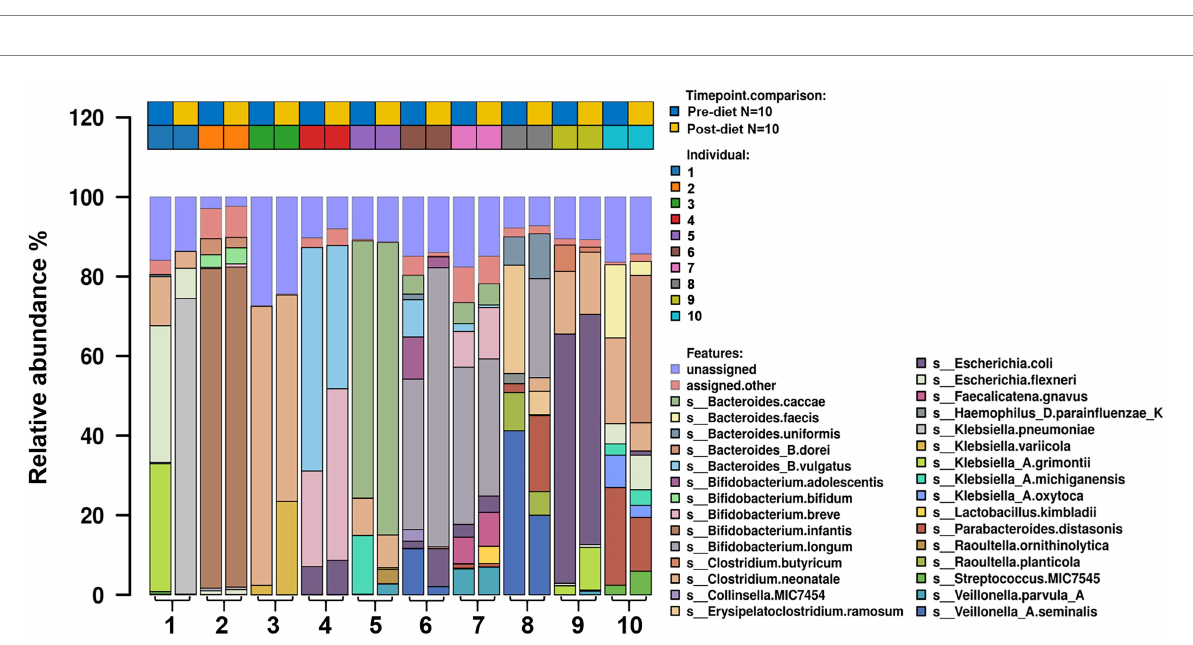
FIGURE 4 The relative abundance of bacterial species in the infant gut microbiome pre- and post-dietary intervention. Only the top most abundant species are